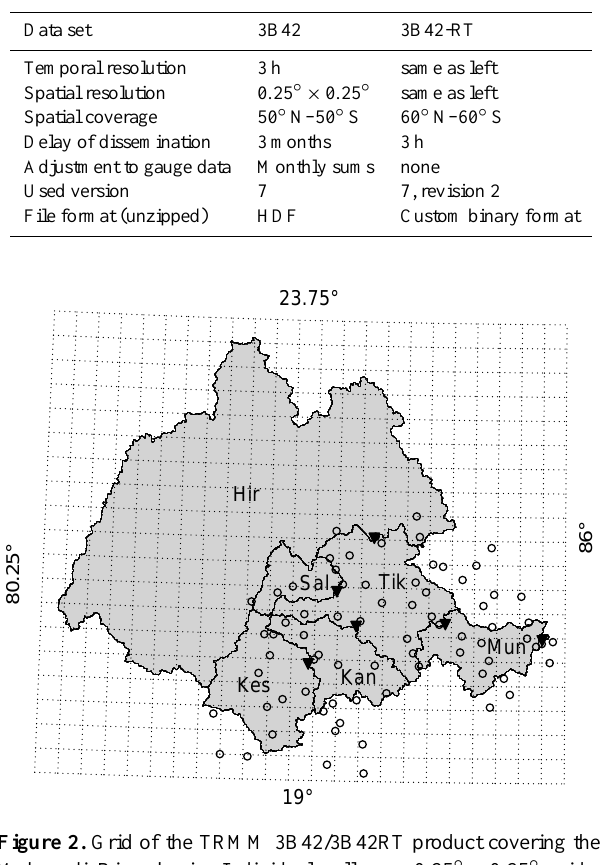
Figure 2. Grid of the TRMM 3B42/3B42RT product covering the Mahanadi River basin. Individual cells are 0 . 25 ◦ × 0 . 25 ◦ wide. Points represent rain-gauges in sub-catchments downstream of the Hirakud Dam, stream gauges are marked by triangles (cf. Fig.